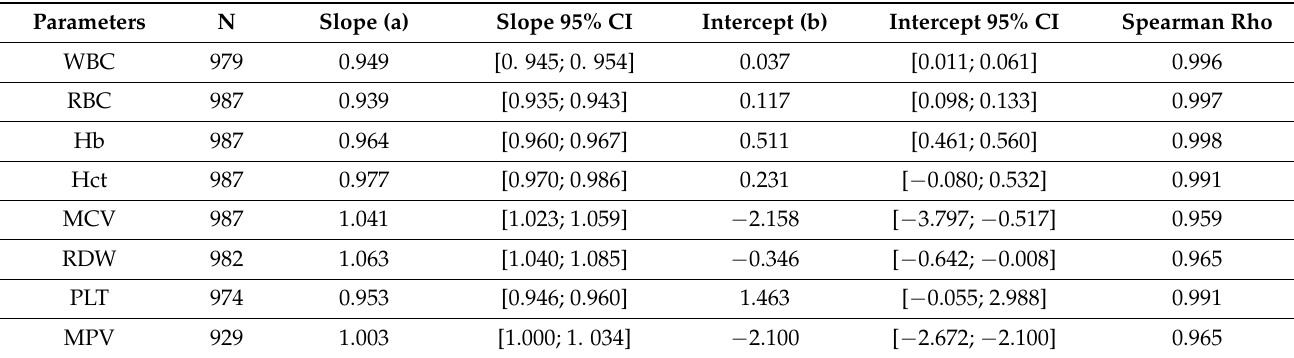
Table 3. Agreement between DxH 900 and XN20; slope and intercept results for degree of association for each parameter analyzed.